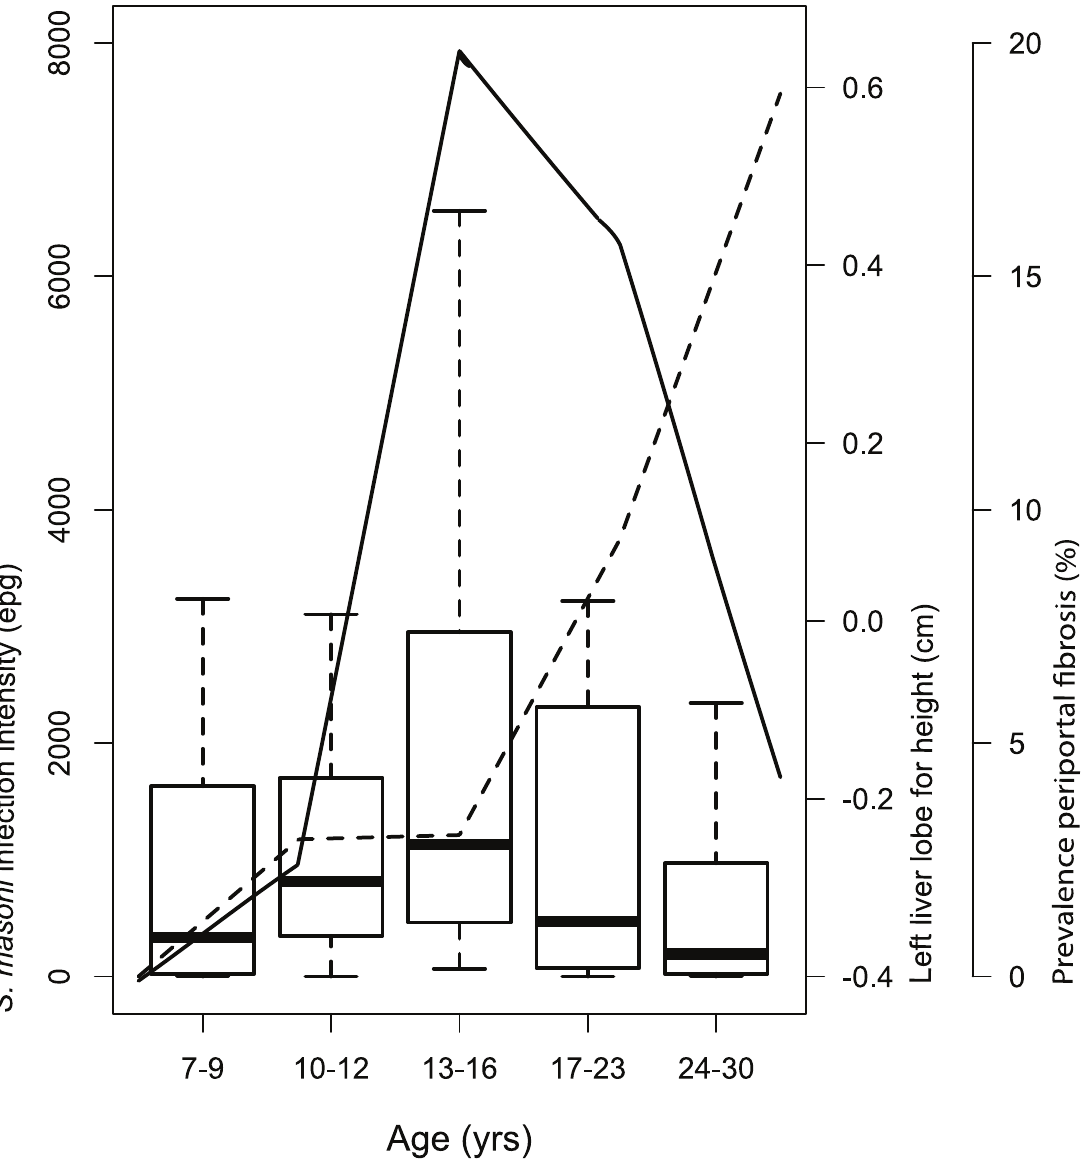
Figure 2. Comparison of S.mansoni egg counts (boxplots), liver size (solid line), and prevalence of severe, non-reversible (pattern E/ F) periportal fibrosis (dashed line) by age. Data is from a randomised cohort selected from the inhabitants of Booma village on the shores of Lake Albert, Uganda. The sole criterion for selection was born in Booma or over 10 years of residence. The left liver lobe was measured in the parasternal line by ultrasound and was standardised for height by linear regression. A comparison of morbidity amongst a larger population from this village and the neighbouring one is published in detail in [24].